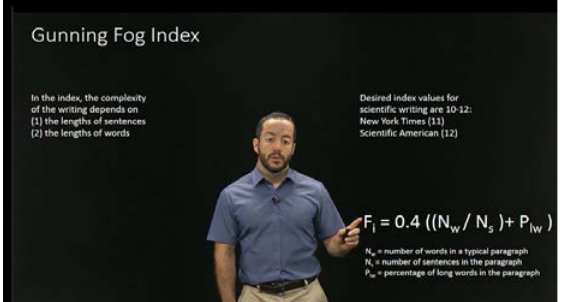
Figure 1. A screenshot of a Treatment Group 1 video featuring a lecturer presenting in front of a slide background showing only text and no other visuals (low